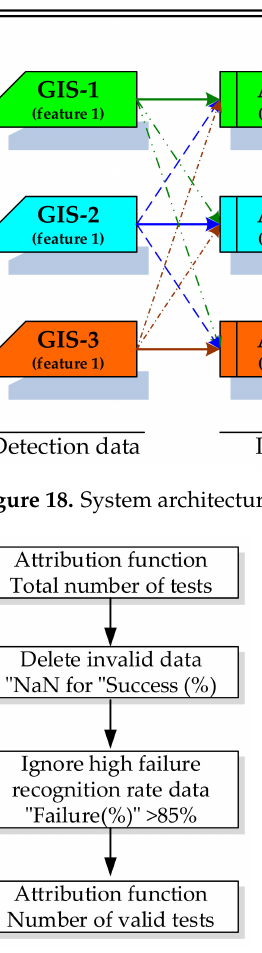
Figure 19. Data filtering process for attribution functions.